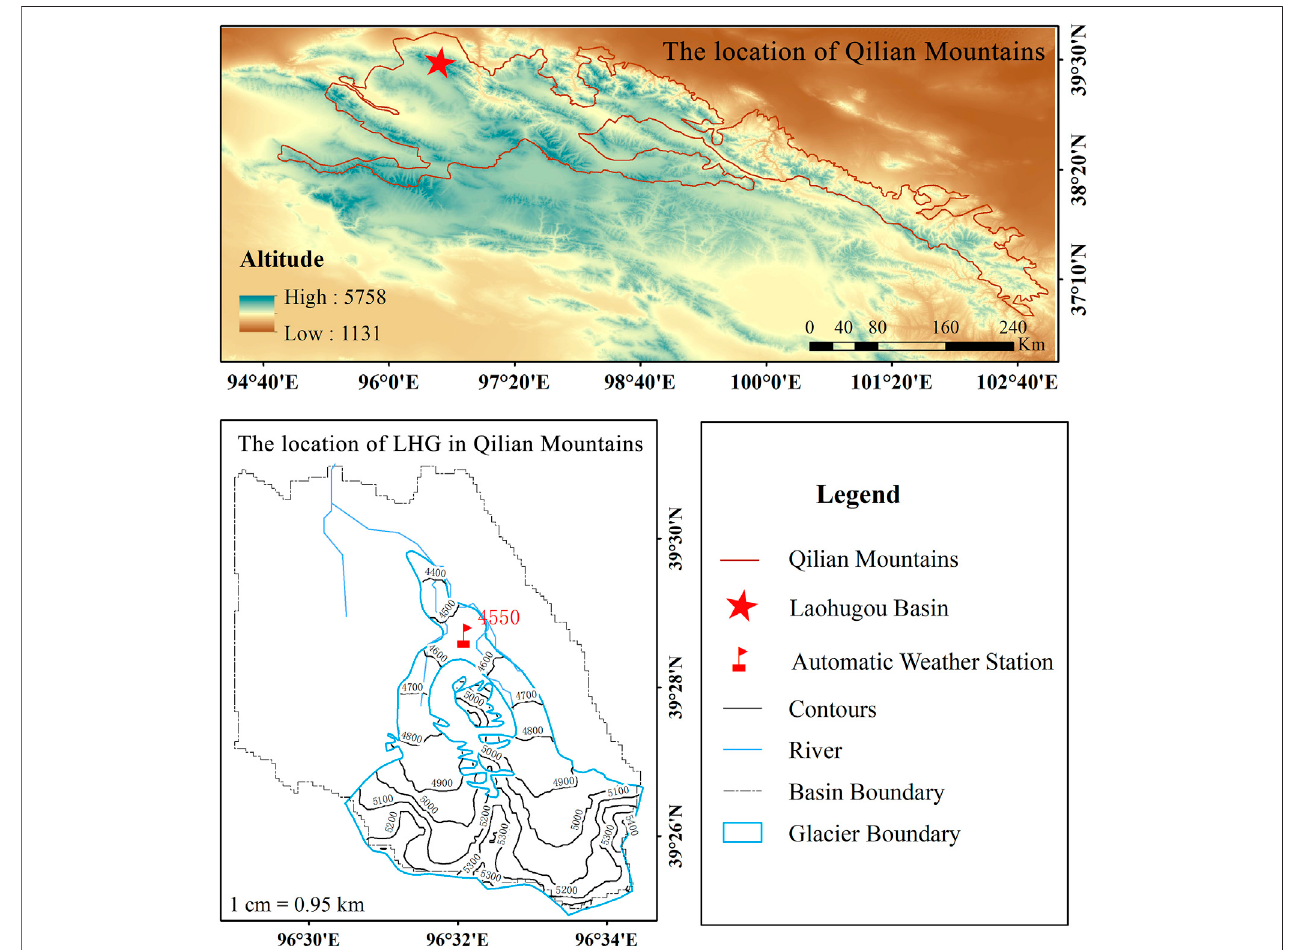
FIGURE 1 | Geographical location of the Laohugou Basin with the spatial distribution of observation stations.